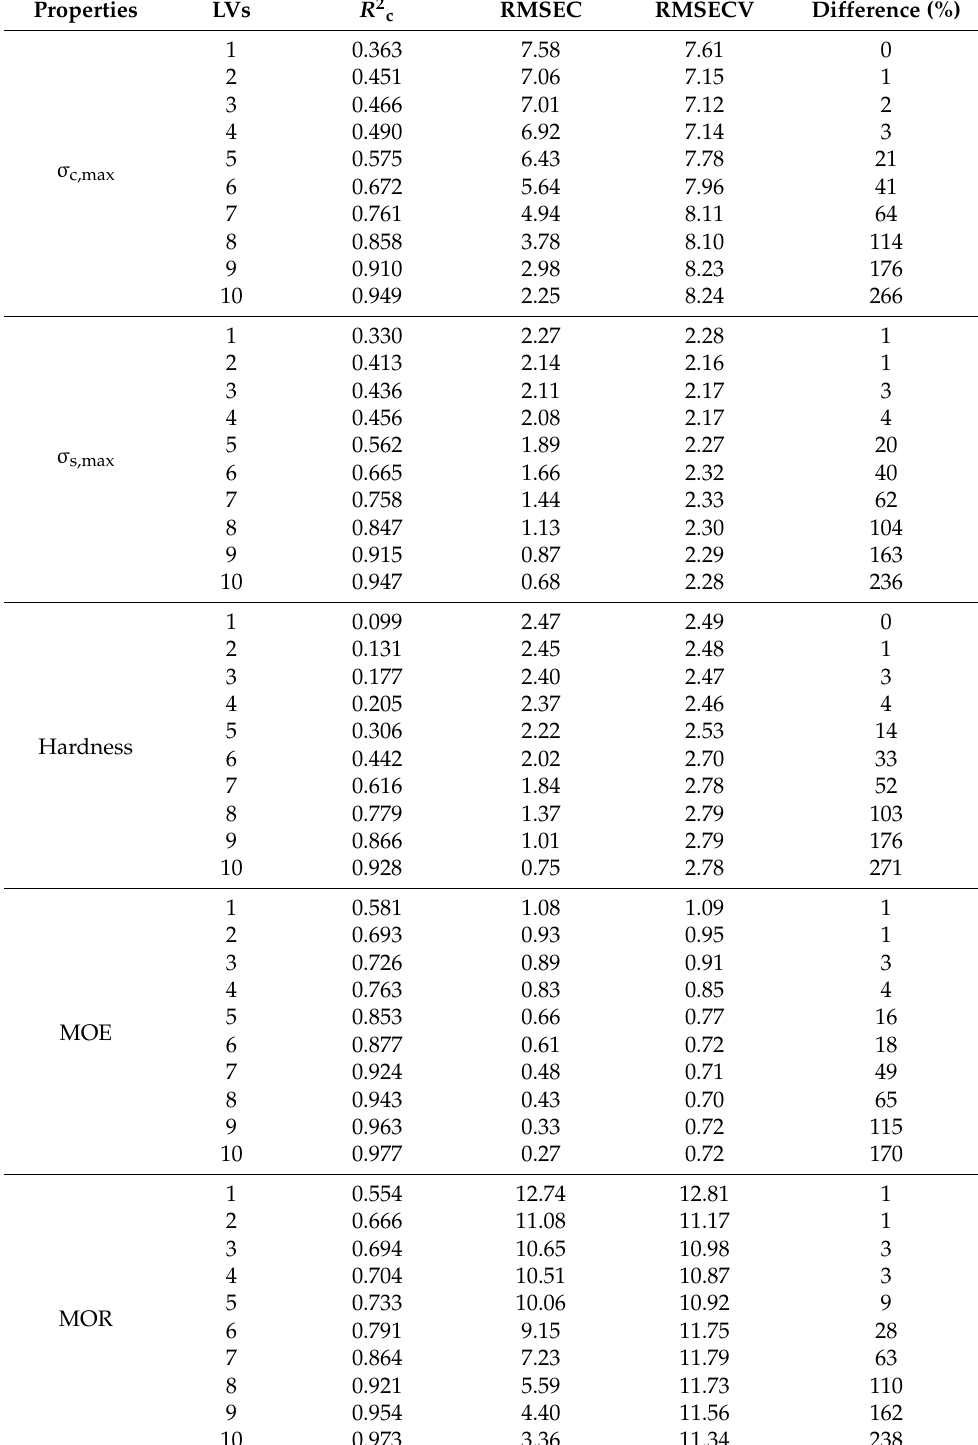
Table 4. PLSR model results with different